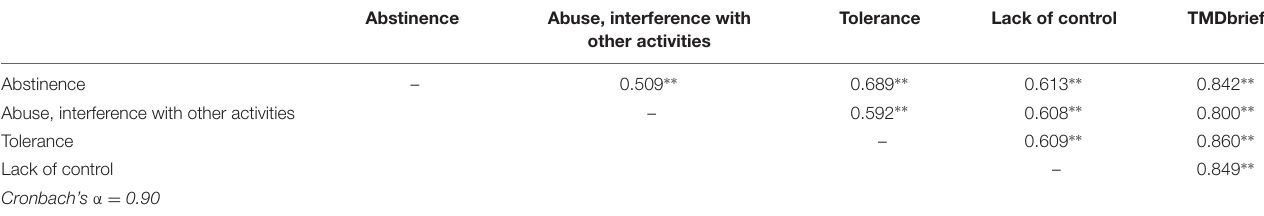
TABLE 5 | Factor correlation matrix (Peru).